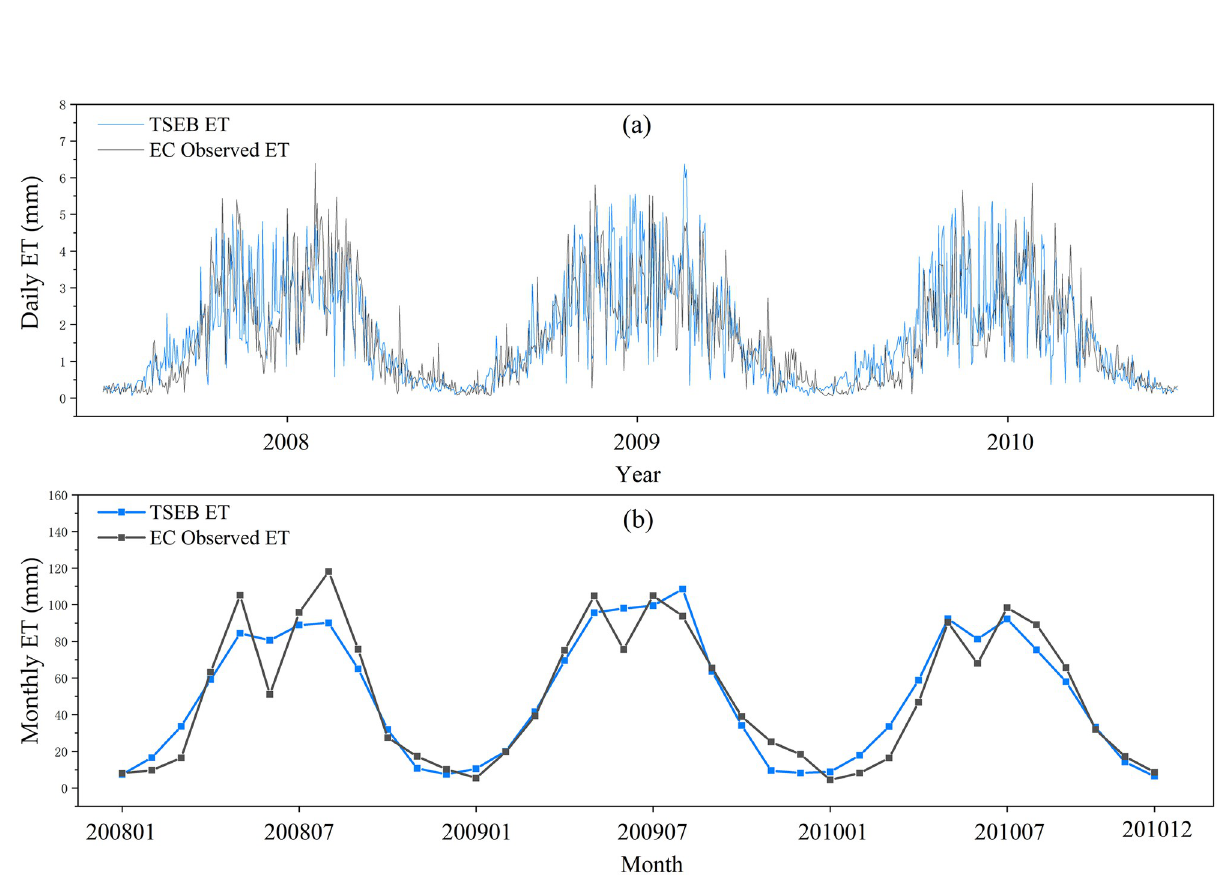
Fig 5. Comparative analysis of simulated daily ET (a) and monthly ET (b) with EC measured ground truth.